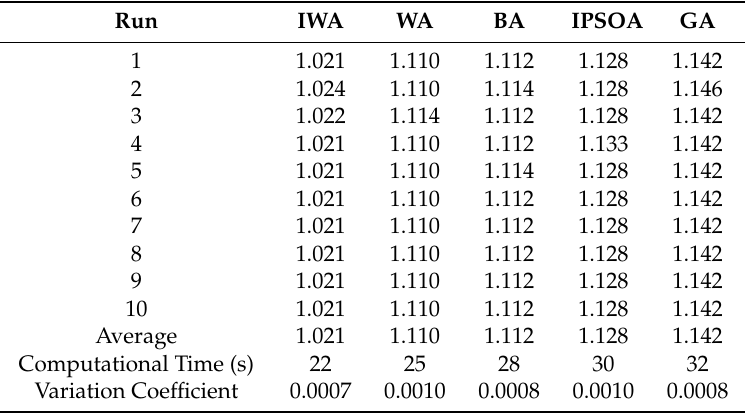
Table 7. Ten random results for medium inflow.